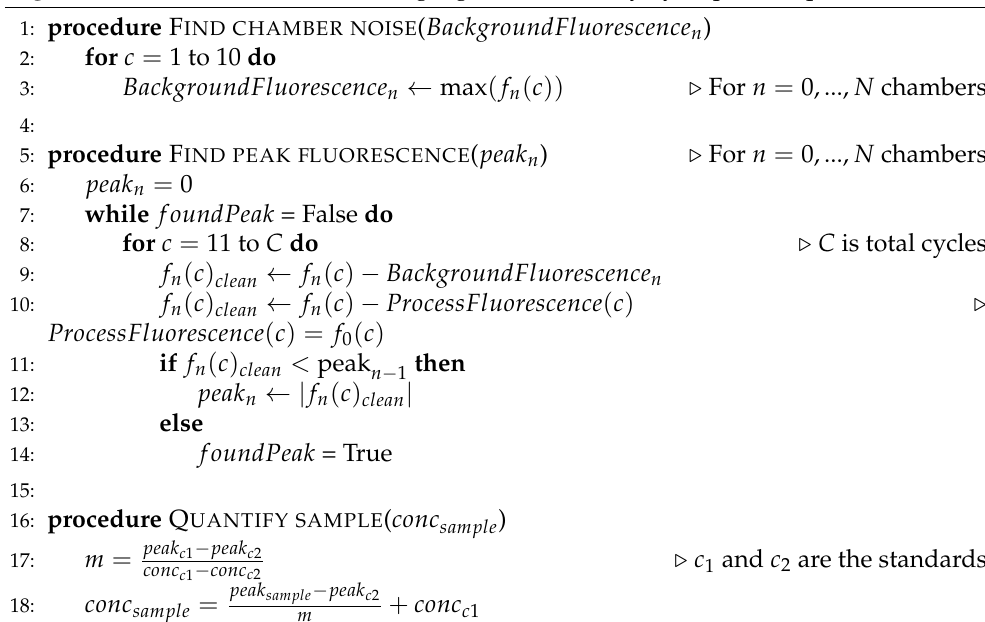
Algorithm 1 PeakFluo: self-calibrating algorithm for early-cycle protein